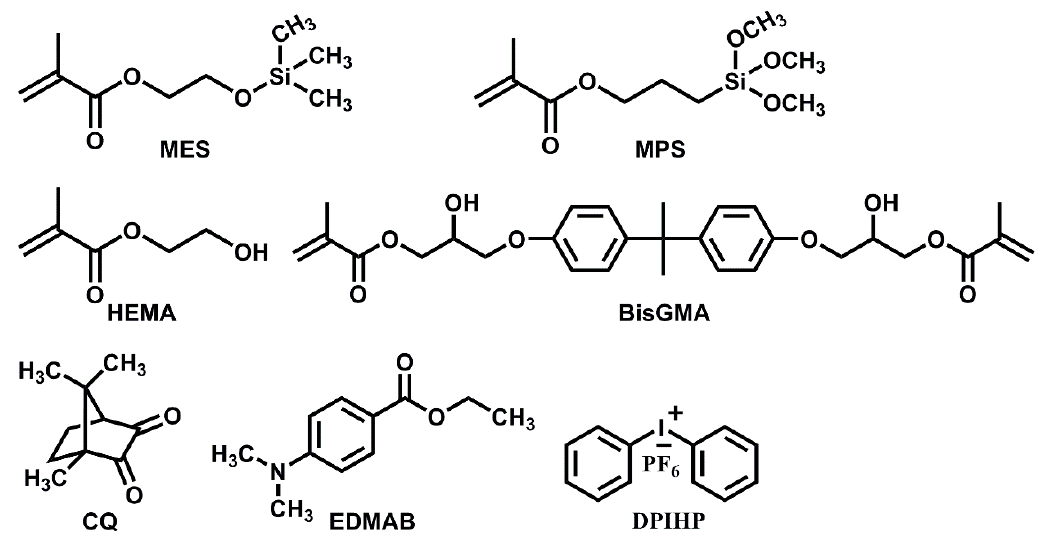
Scheme 1 . Chemical structures of components used in the formulations.